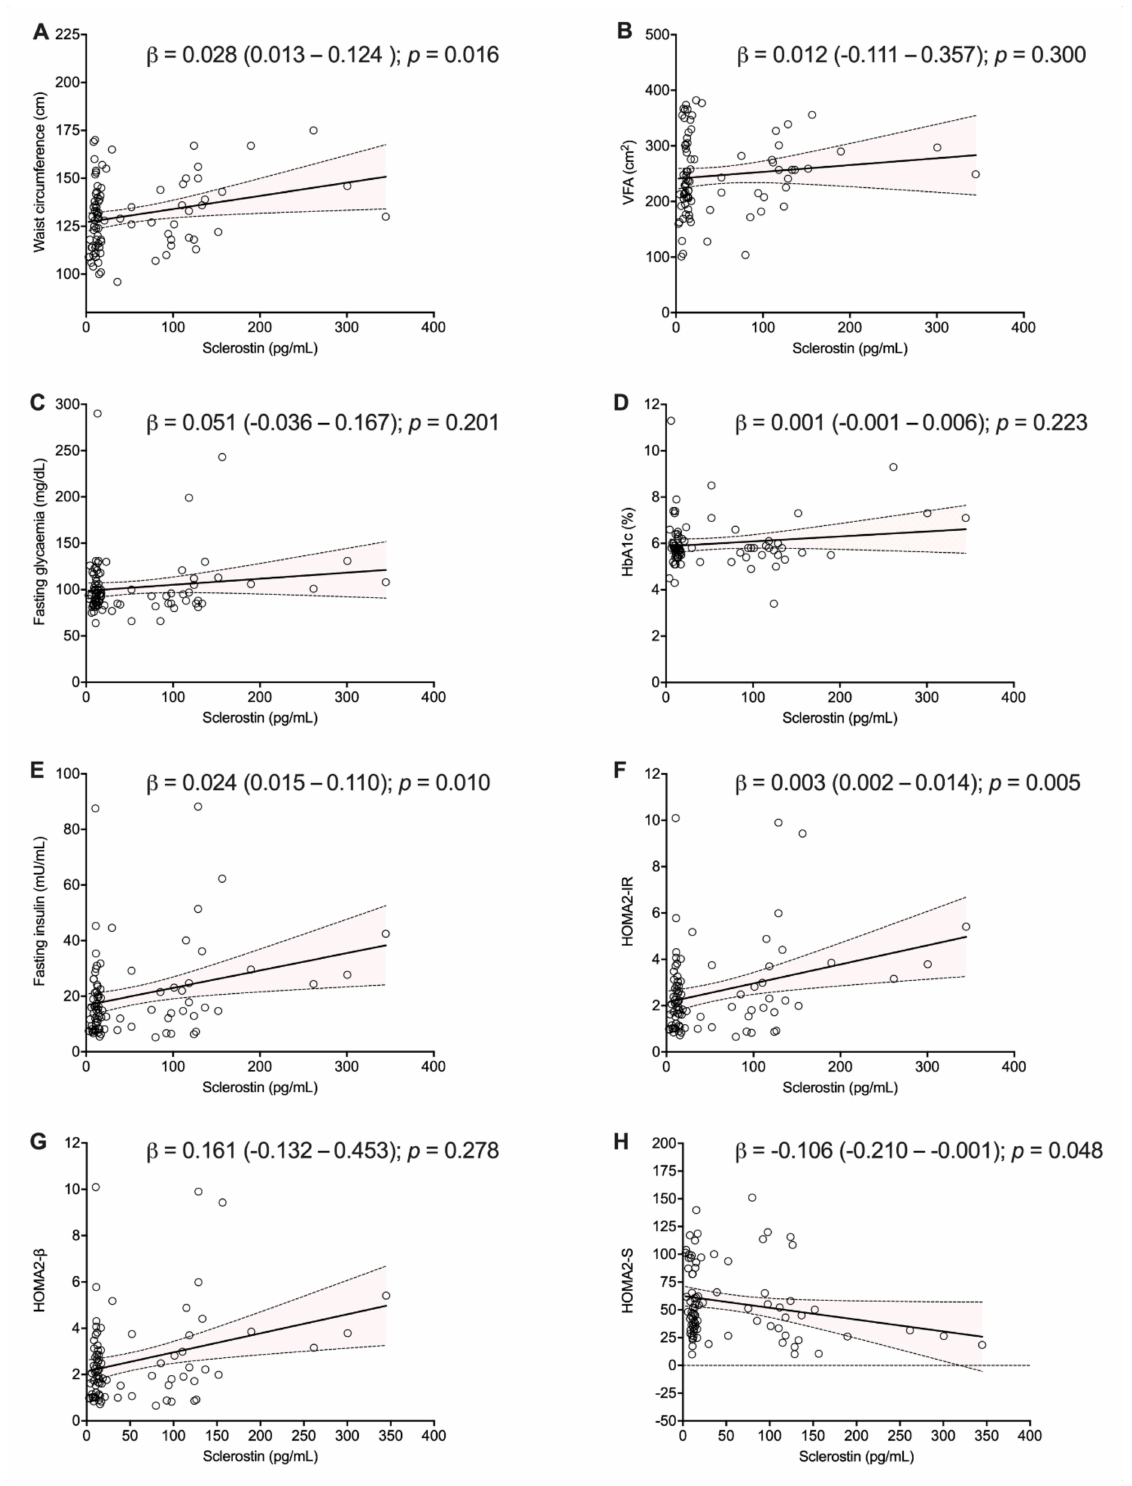
Figure 1. Serum sclerostin is independently associated with anthropometric index of fat mass and impaired insulin sensitivity. Linear regression analysis showing the association of sclerostin with waist circumference ( A ) and ultrasound- assessed visceral fat mass (VFA) ( B ). We also analyzed the potential associations with indexes of impaired insulin sensitivity: fasting glycemia ( C ), glycated hemoglobin ( D ), fasting insulin ( E ) and the homeostatic model assessment (HOMA)2 for insulin resistance (IR) ( F ), β cell function ( β ) ( G ) and peripheral insulin sensitivity (S) ( H